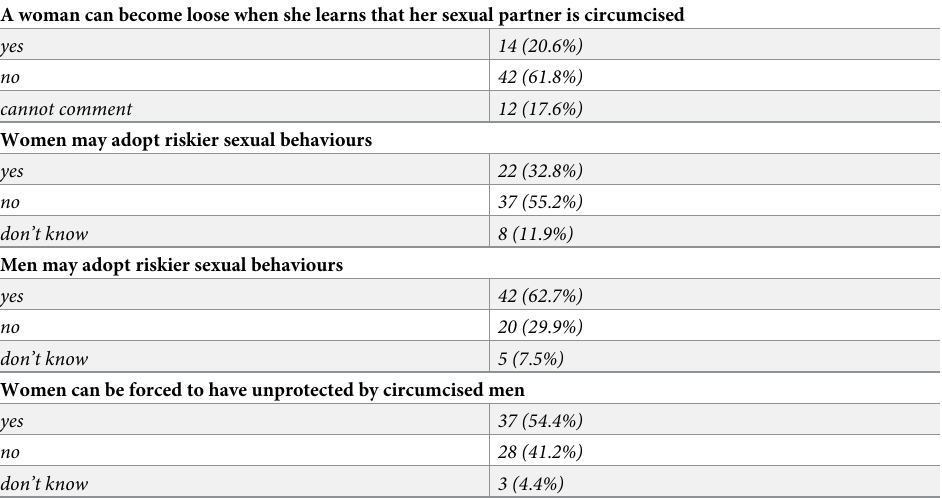
Table 5. Summary descriptive analysis of knowledge on MC risk